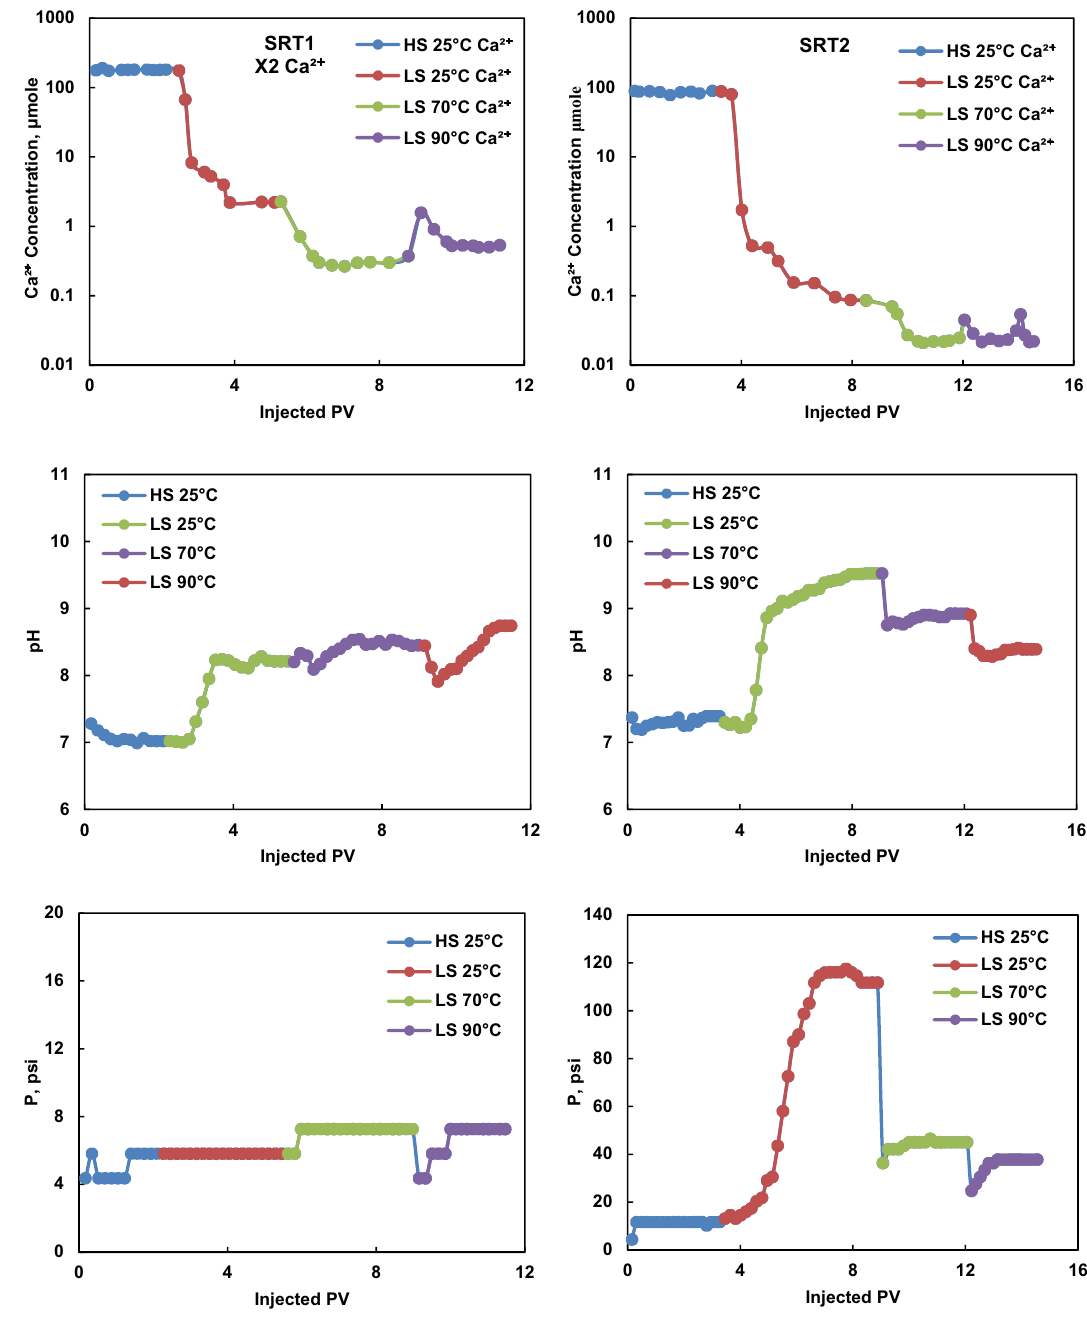
Fig. 10 Surface reactivity test analyses, SRT1 and